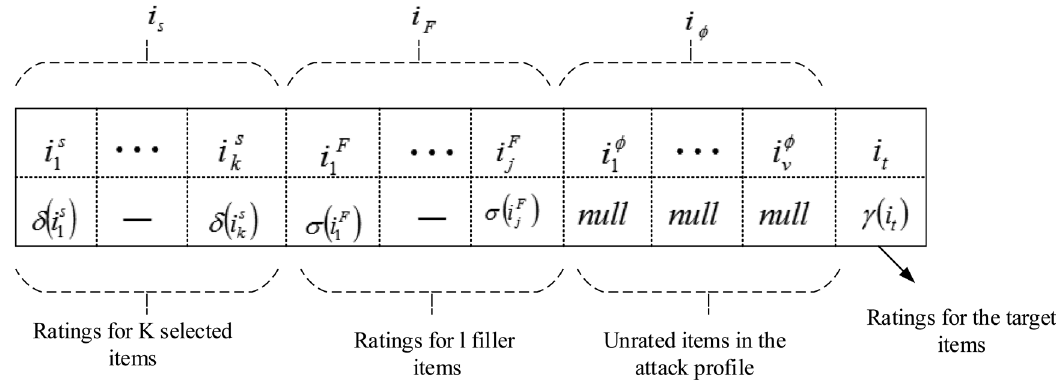
Figure 1: Shilling attack